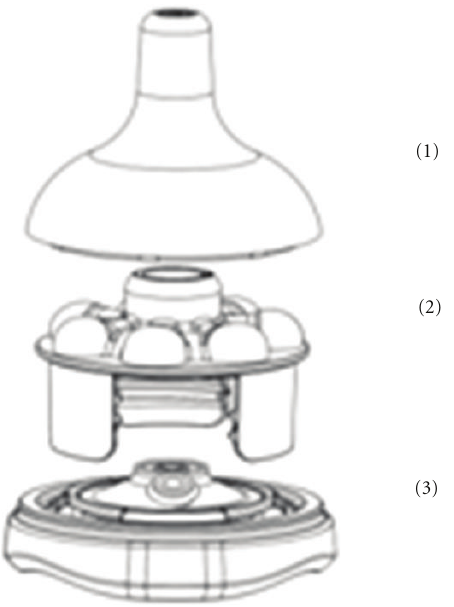
Figure 1: The experimental teat was comprised of 3 parts: (1) silicone teat, (2) middle teat base with raised support areas for the teat and a milk flow component, and (3) base contained a duck bill valve to vent the